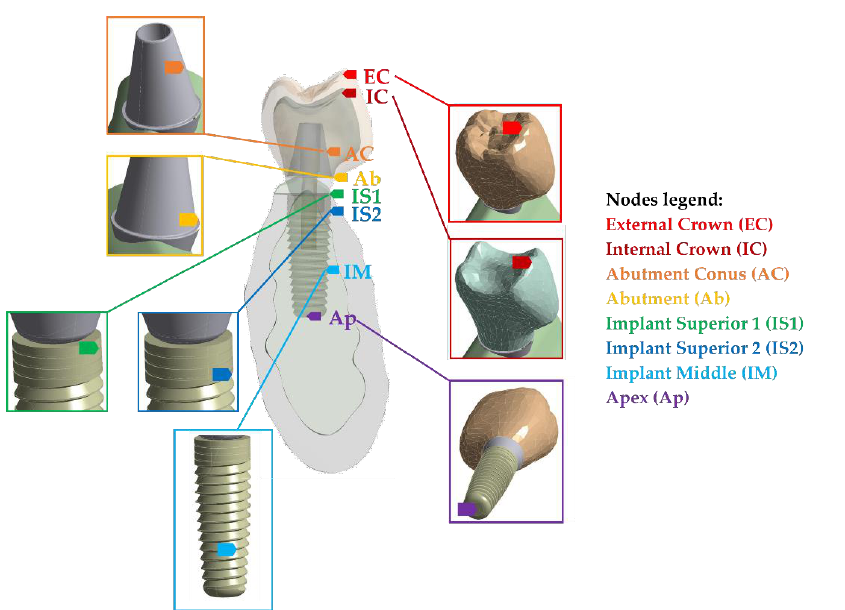
Figure 3. Comparison of the dynamic behavior of Von Mises stress, see Figure 4 for nodes’ locations. ( A ) Four superior nodes. Note the significant difference in stress between the external crown (EC) and the internal crown (IC). ( B ) Four inferior nodes. Note the difference in stress between the apex (Ap) and the implant superior 2 (IS2) nodes.